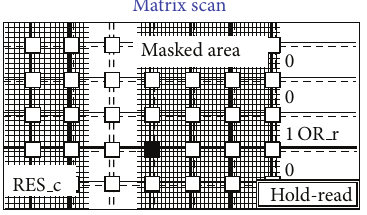
Figure 13: Last selected column.